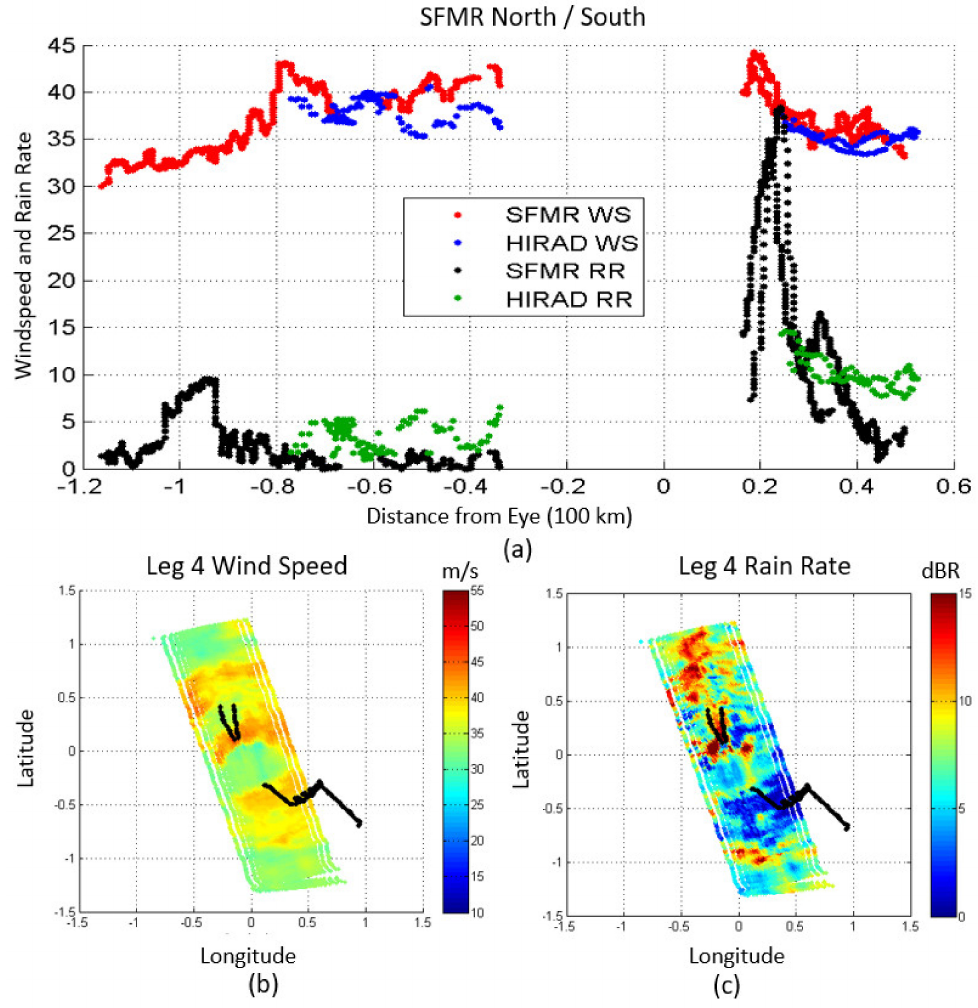
Figure 14. HIRAD to SFMR geophysical retrieval comparisons for Hurricane Gonzalo Leg 4, where in ( a ) for the upper panel, SFMR/HIRAD results are WS (red/blue) and RR (black/green), respectively. The lower panels ( b , c ) show the HIRAD WS and RR measurements, with the SFMR measurement location in